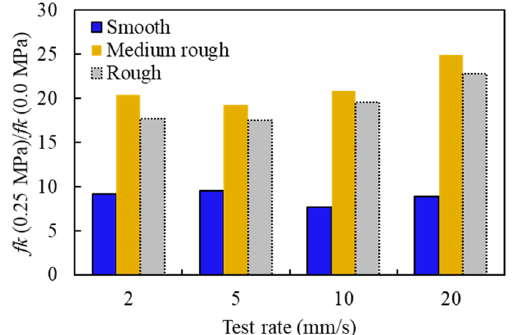
Figure 18. Variation in friction force with test rate for different concrete surface